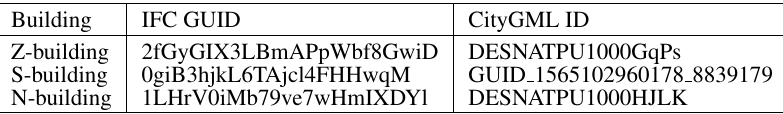
Table 1. Correspondence links between buildings in IFC and CityGML